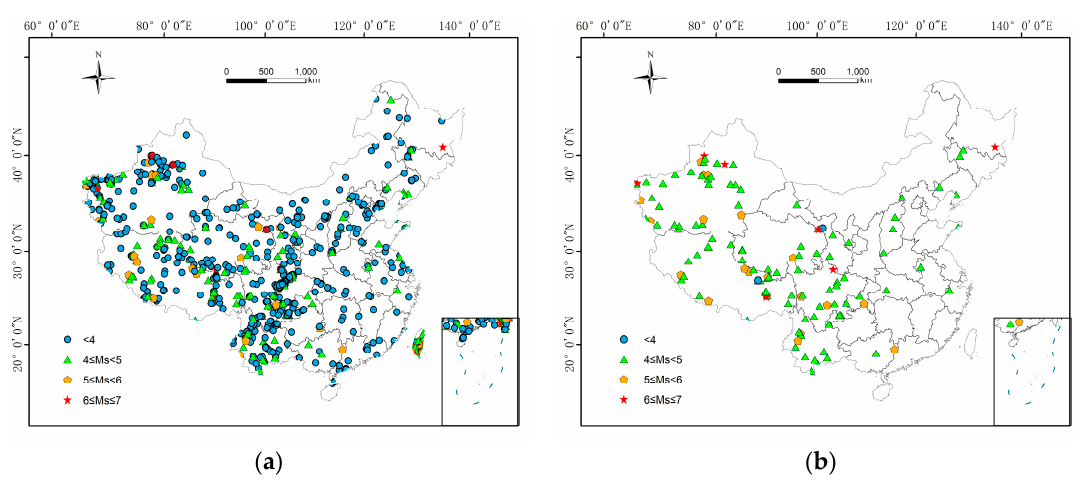
Figure 1. ( a ) Spatial distribution of earthquake events from news reports, ( b ) spatial distribution of earthquake events from professional reports. Table 6. Evaluation results of earthquake extraction.